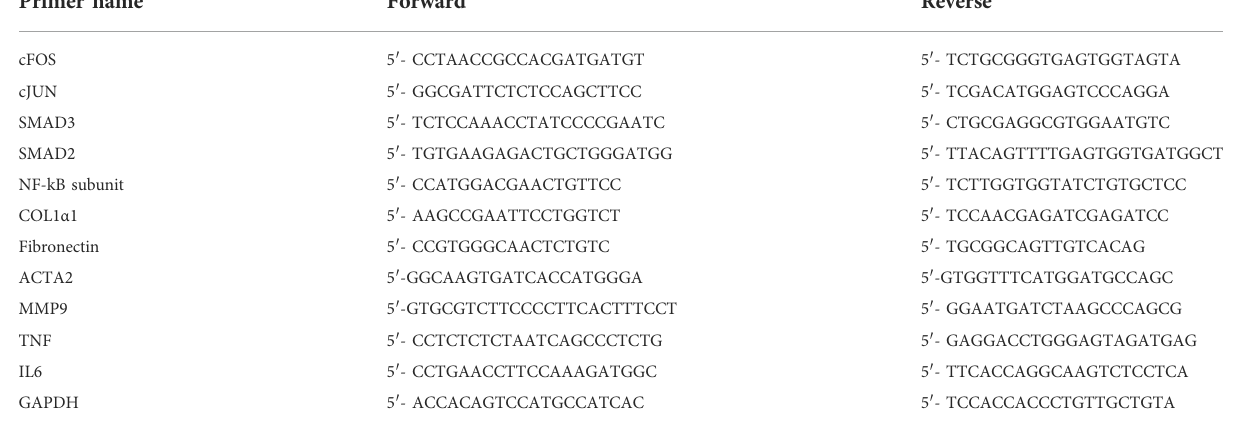
TABLE 1 Primer sequences used for Real-Time